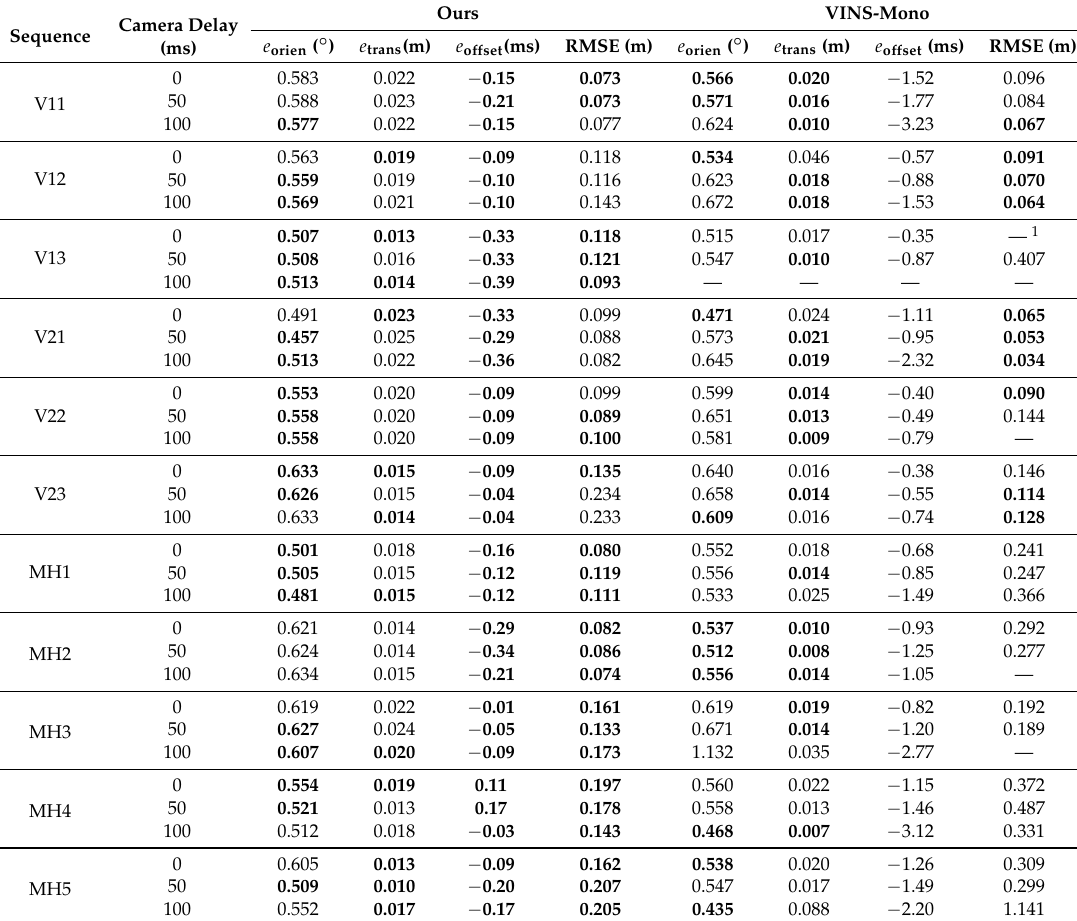
Table 1. Spatial-temporal calibration error and keyframe trajectory